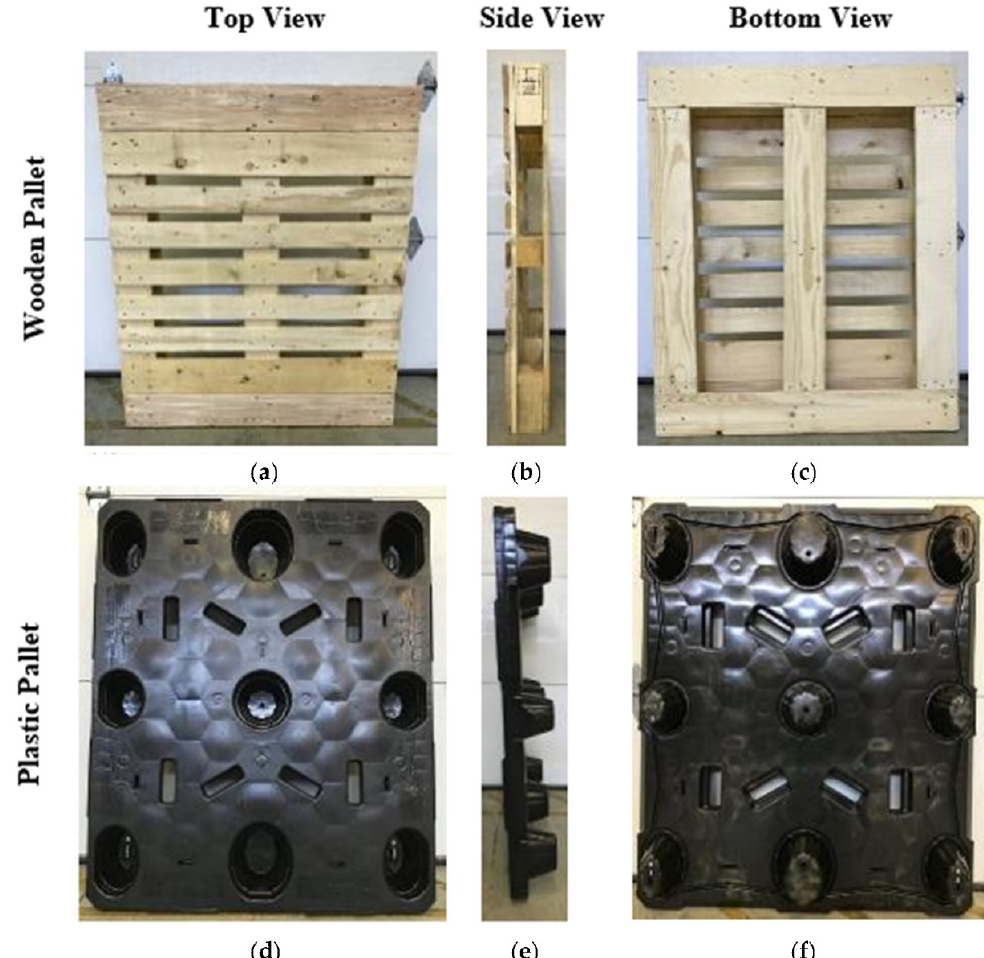
Figure 2. Representative picture of: ( a ): top; ( b ) side; and ( c ) bottom view of the wooden pallet; and